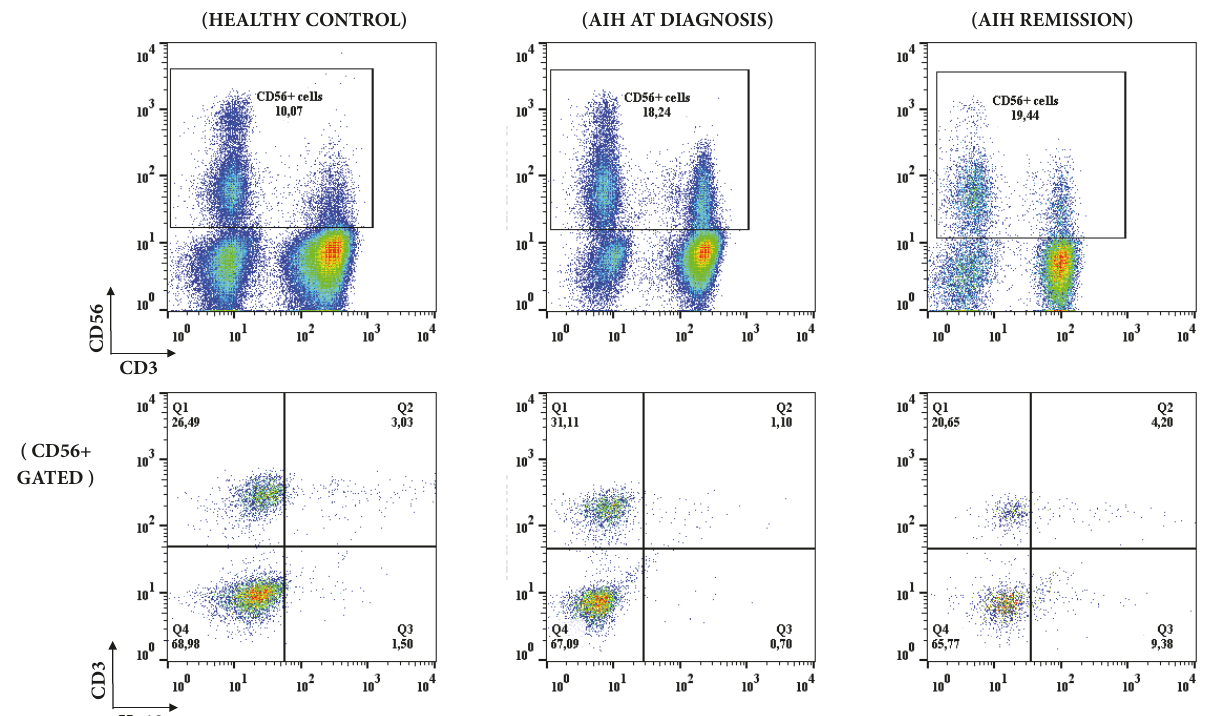
Figure 1: Schematic representation of phenotypic and intracellular IL-10 expression analysis in NKT (CD3+CD56+) and NK (CD3- CD56+) cells from a healthy donor and an AIH patient at diagnosis 6 months after immunosuppressive treatment, at the time of